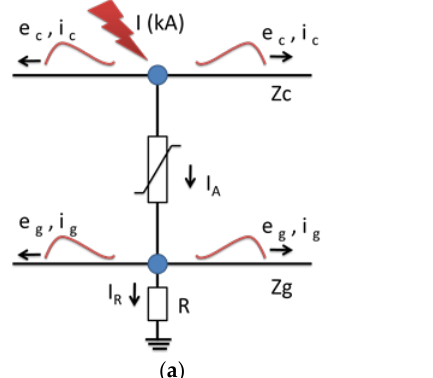
Figure 13. Result of a lightning strike to the phase conductor and overhead ground wire when the arrester is installed; ( a ) Strike to the phase conductor; ( b ) Strike to the overhead ground wire. The crest voltage at the phase conductor is given by